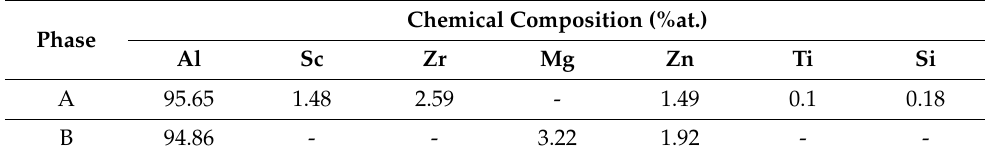
Table 4. EDS analysis of points A and B in Figure 8. Phase